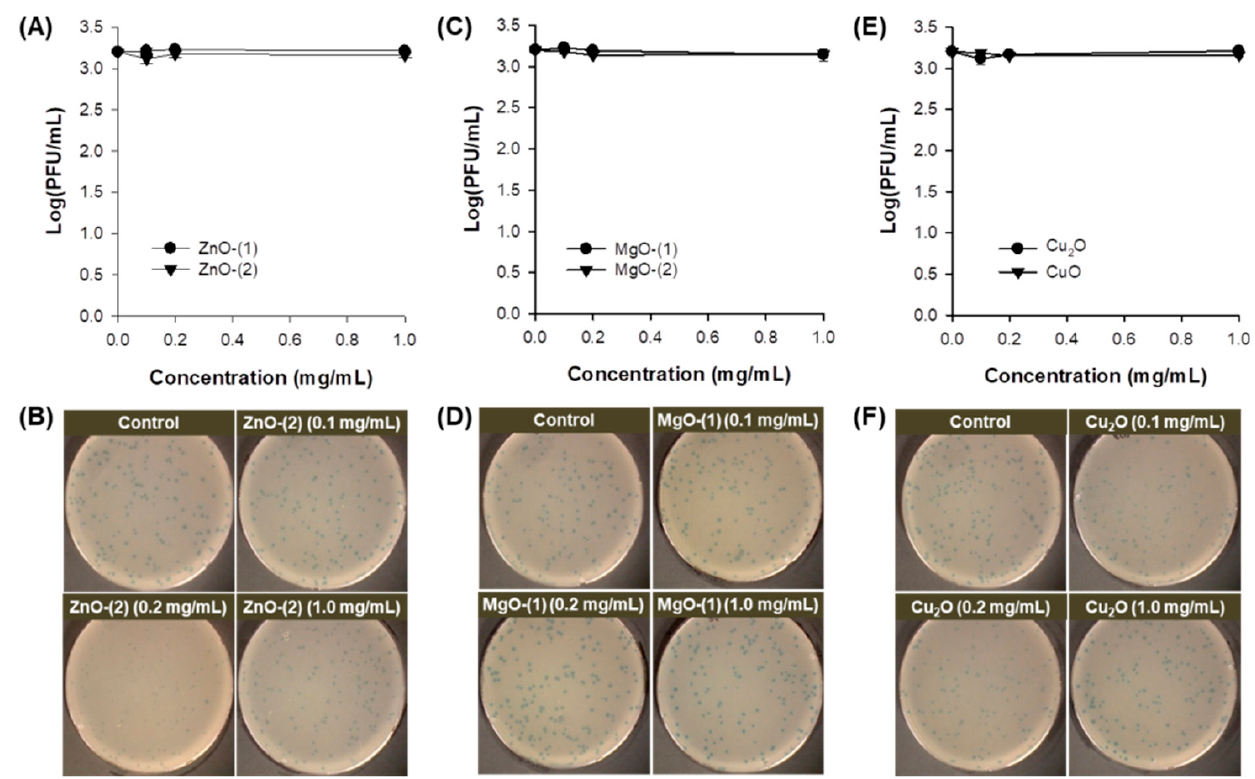
Figure 4. Antimicrobial effect of metal oxide (MO) particles against phage: plots of concentration (mg/mL) versus log(PFU/mL) and the representative plate images of ( A , B ) ZnO-(1), and ZnO-(2); ( C , D ) MgO-(1), and MgO-(2); and ( E , F ) Cu 2 O, and CuO.